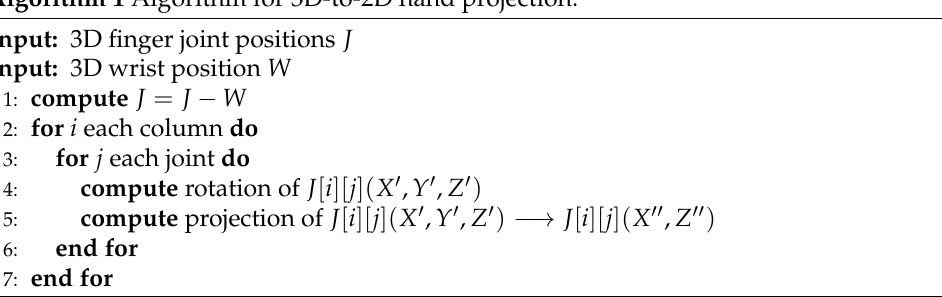
Figure 14. 3D-to-2D hand projection: ( a ) 3D hand skeleton detection, ( b ) Rotation, and ( c ) 2D projection. Algorithm 1 depicts the algorithm of 3D-to-2D hand projection. Algorithm 1 Algorithm for 3D-to-2D hand